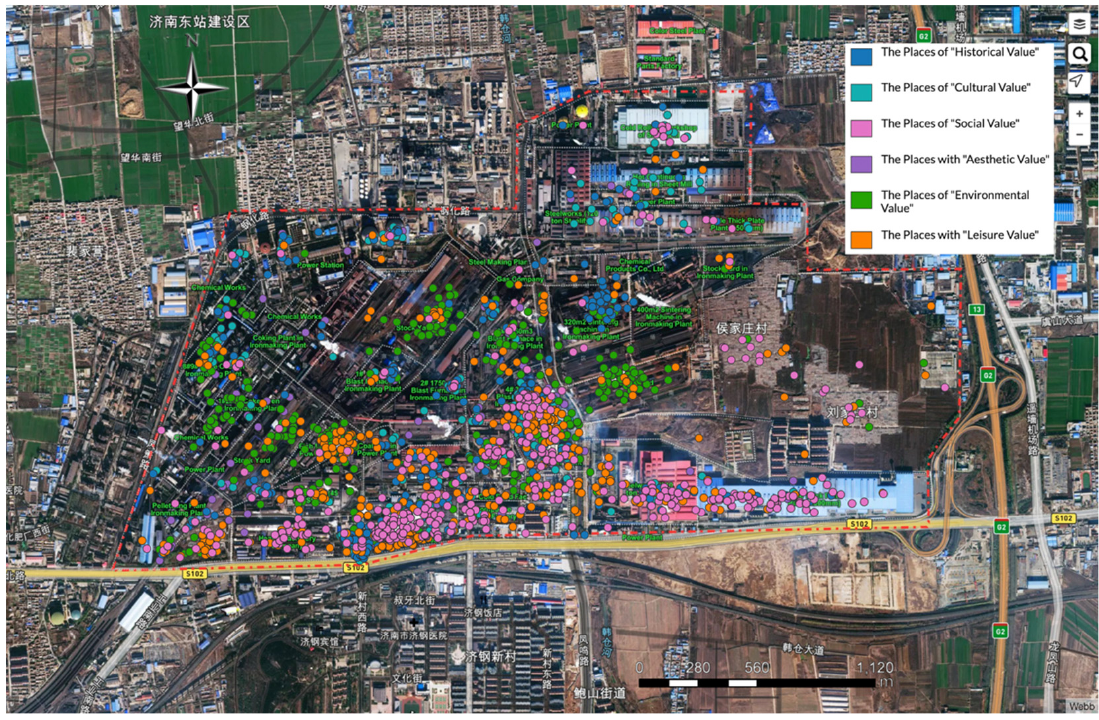
Figure 2. All points interviewees marked (The basemap is made based on Mapbox Map Service China Edition, and Chinese can be ignored.).